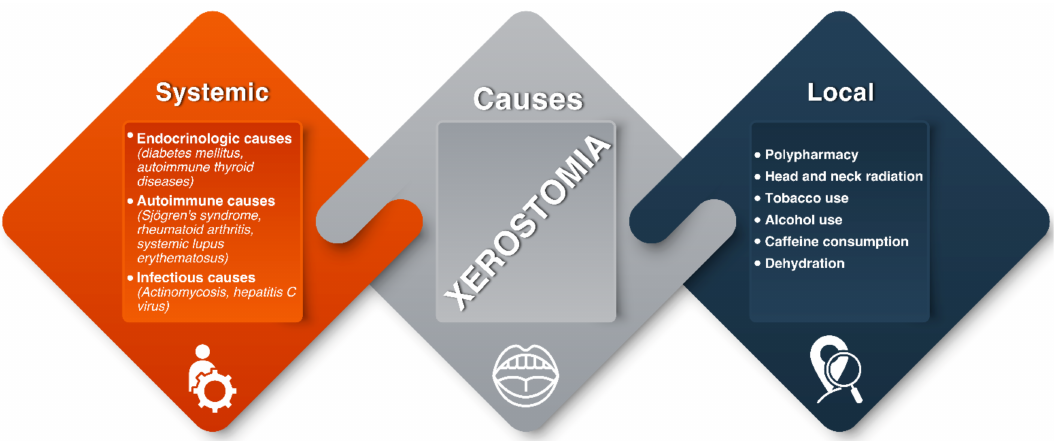
Figure 2. The classification of xerostomia’s causes as systemic or